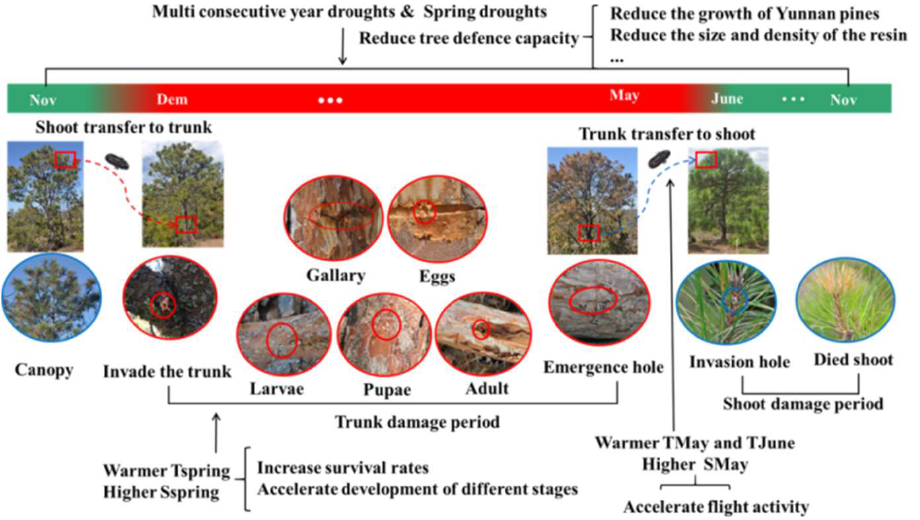
Figure 10. Influence of important climate variables on pine shoot beetle outbreak; The life cycle of Tomicus spp. Red indicates the trunk damage period, and blue indicates the shoot damage period.